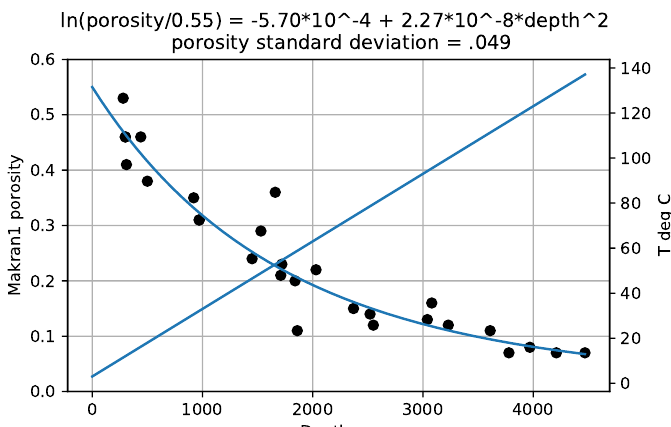
Figure 1. Akita porosity trend.